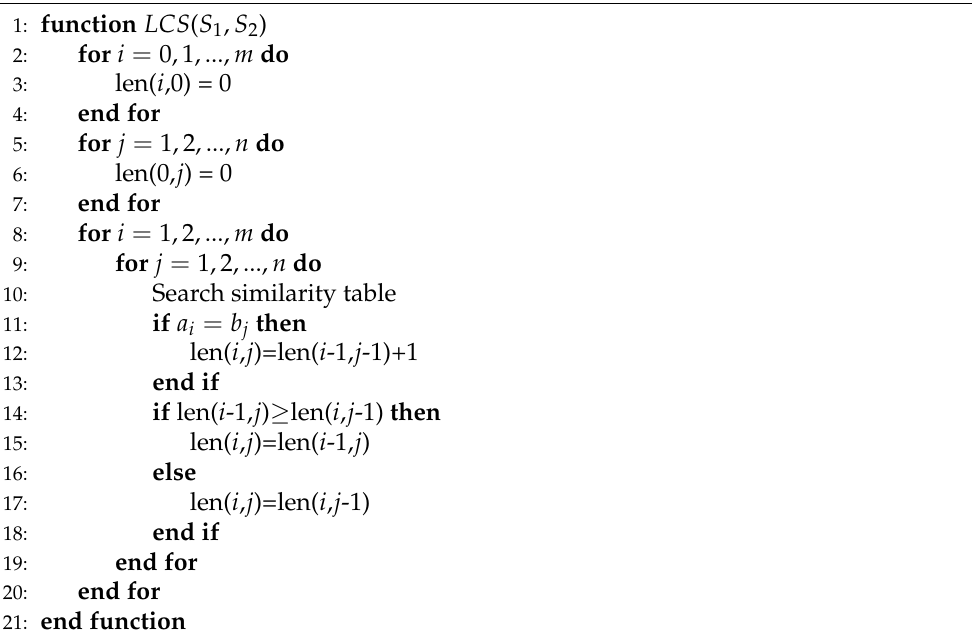
Algorithm 2 Revised LCS algorithm.